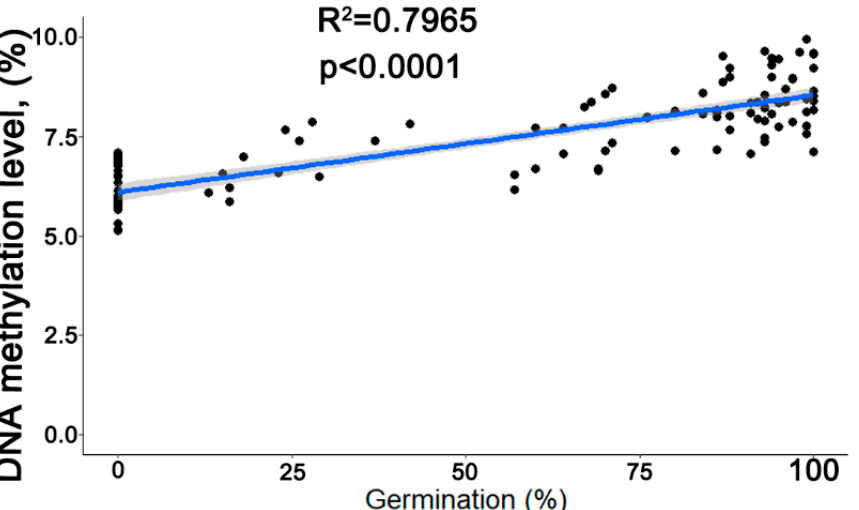
Figure 6. Correlation between germination and global 5mC level for three combined seed lots composed of non-desiccated and desiccated seeds. The grey area represents the level of confidence interval at 0.95 ( n = 120).